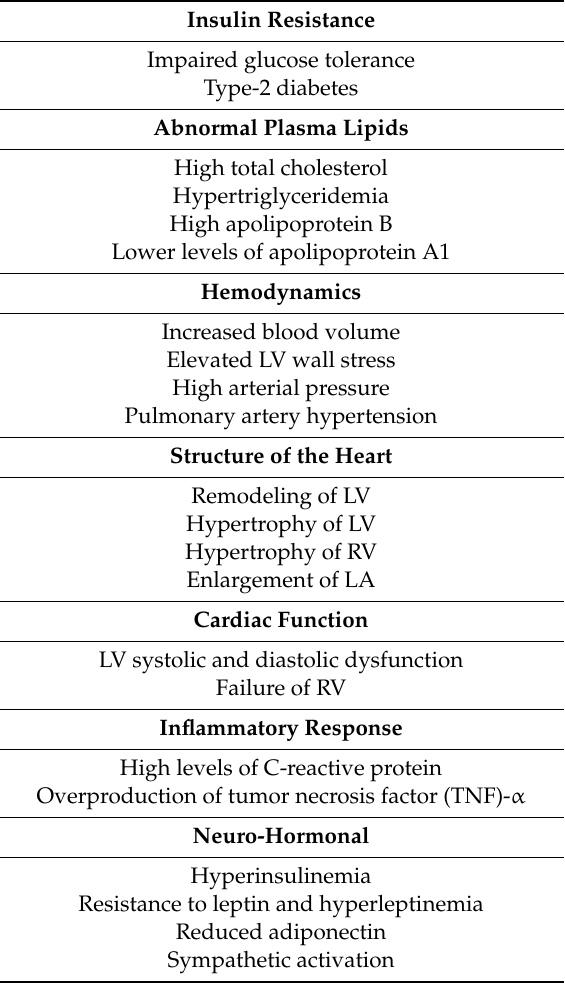
Table 1. Detrimental e ff ects of